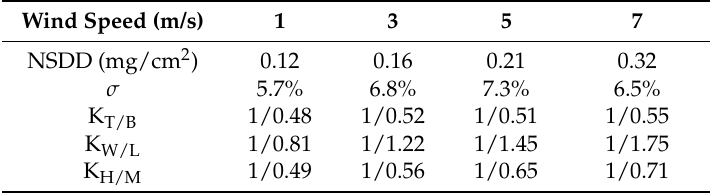
Table 4. Average NSDD, K T/B , K W/L , K H/M under different wind speed.